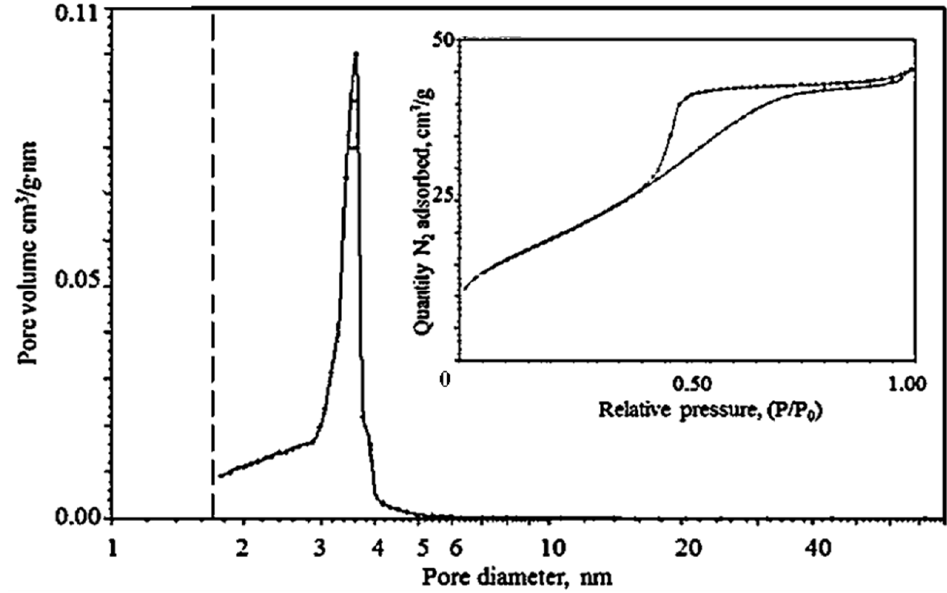
Figure 6. N 2 adsorption–desorption data for the nano-zirconia powder: pore size distribution and adsorption isotherms (inset).